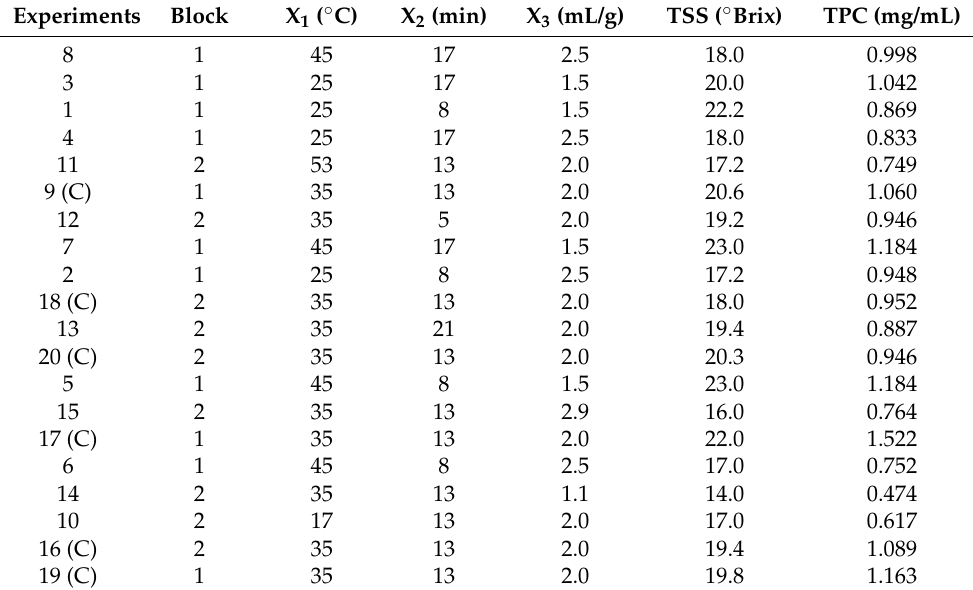
Table 1. UAE optimization by three-level central composite design (CCD).